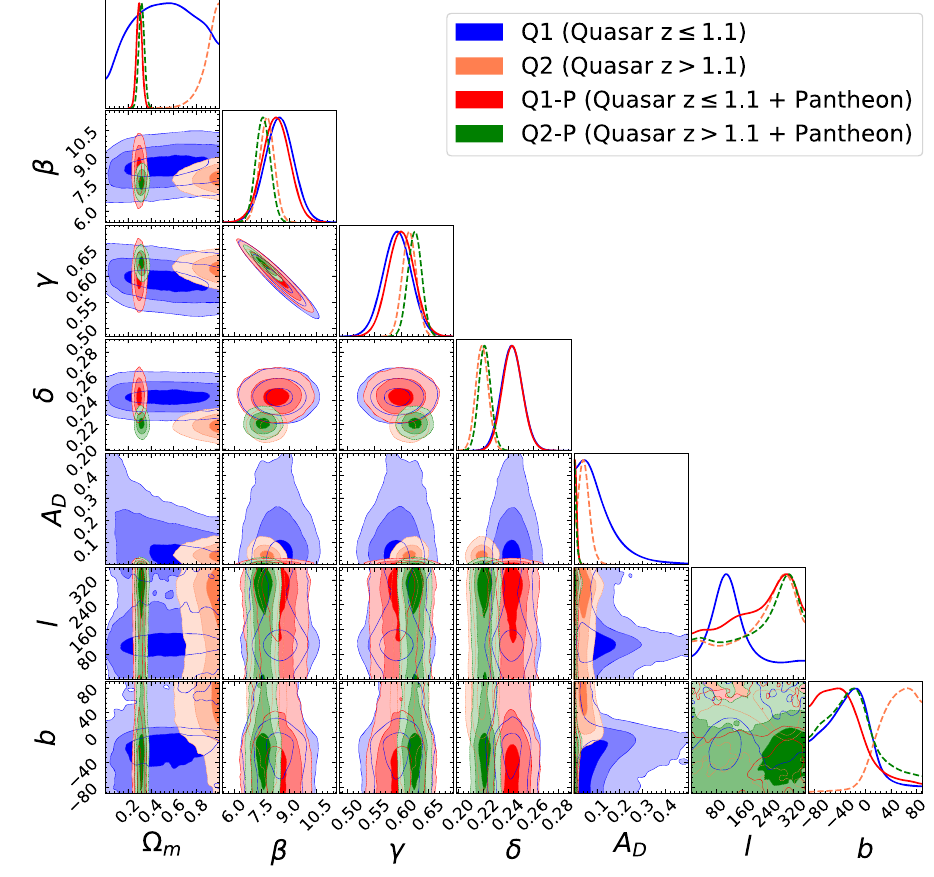
Fig. 4 The marginalized posterior distribution of the parameters in the Finslerian cosmological model. The blue lines denote the results from dataset Q1, the orange lines denote the results from dataset Q2, the red lines represent the results from dataset Q1-P, and the green lines represent the results from dataset Q2-P